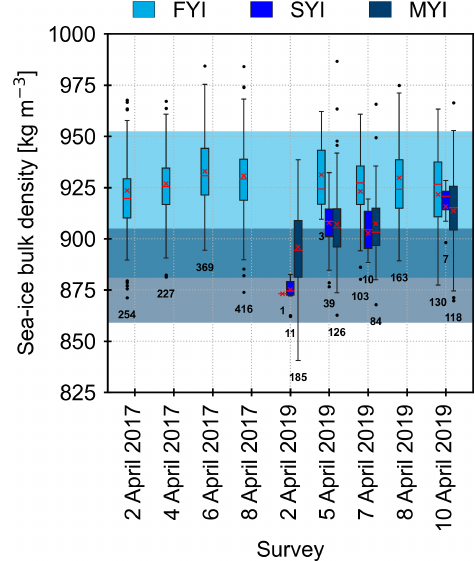
Figure 6. Sea-ice bulk density by ice type and survey in the 800m length scale showing the interquartile range (IQR, Q3–Q1, boxes), the median values (red lines), the inverse-uncertainty weighted mean (red crosses, Table 3), and outliers (beyond 1.5 × IQR, dots). The numbers below the boxes correspond to the number of aver- aged values contained in each ice type of each individual survey. The shading on the background shows the ± 1 standard deviation range around the A10 mean FYI (light blue) and MYI (dark blue) densities,